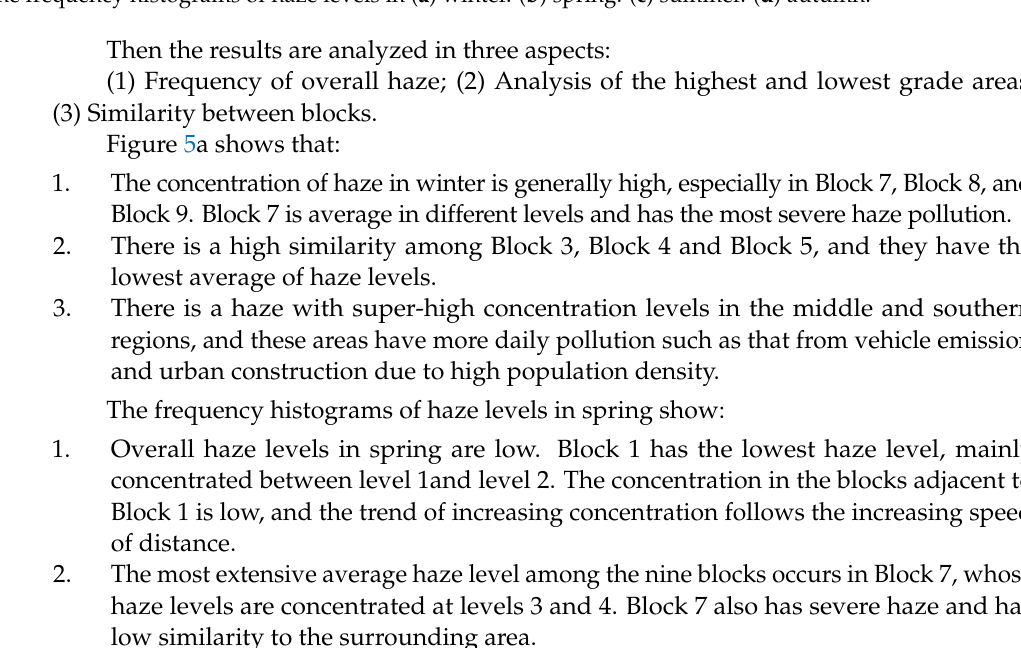
Figure 5. The frequency histograms of haze levels in ( a ) winter. ( b ) spring. ( c ) summer. ( d ) autumn.